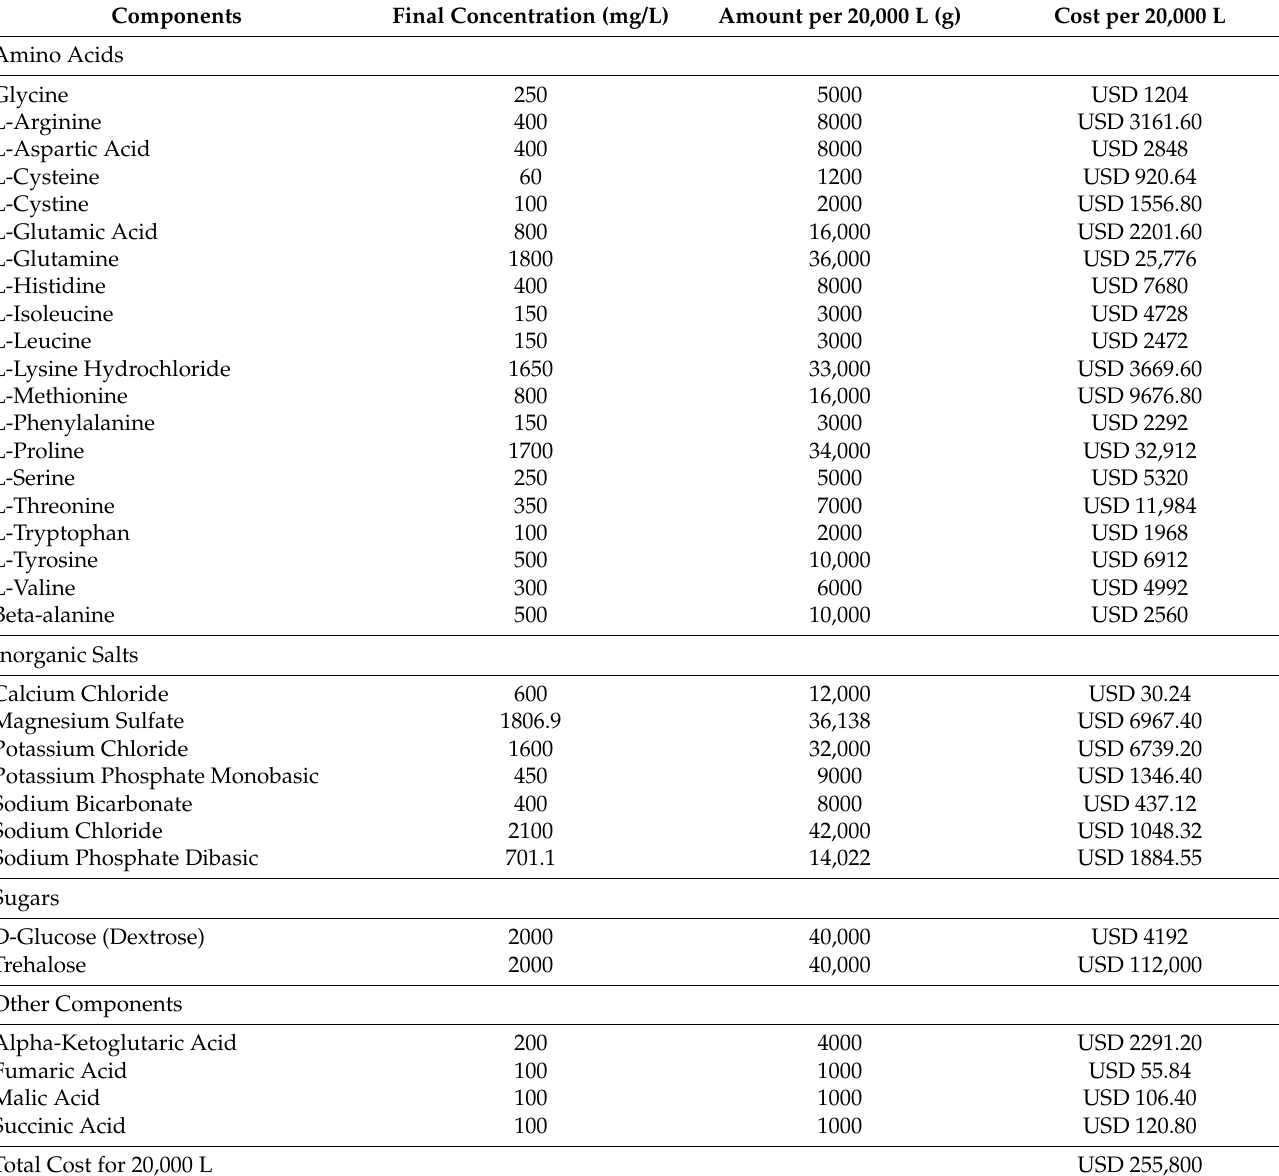
Table A6. Cost of components within Schneider’s basal medium and their relative cost contribution to a hypothetical 20,000 L batch.